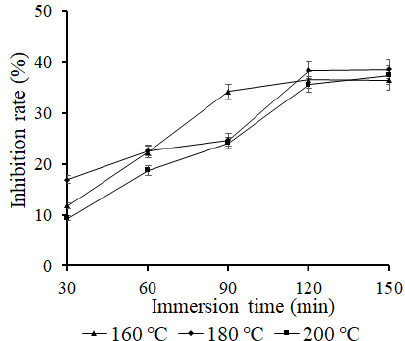
Figure 3. Effect of immersion time on acrylamide inhibition rate in fried potato chips.